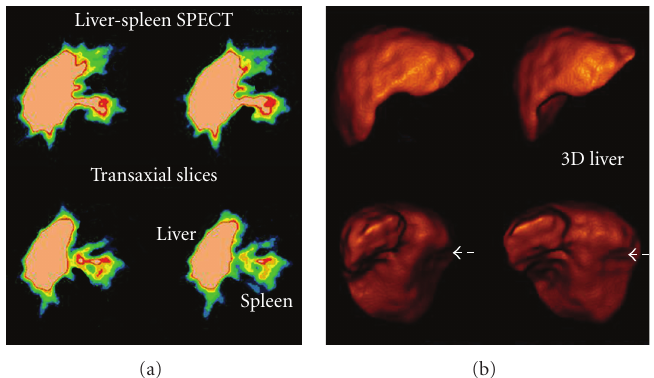
Figure 9: A liver-spleen study SPECT and 3D SPECT. (a) Transverse slices, prefiltered only by Ramp filter could emerge a small piece of the ruptured spleen. (b) 3D SPECT reconstruction by ramp-Hanning filters (Hanning cut-o ff frequency equal to 0.8 cycles/cm), a threshold 25% and 15% gradient, could show the liver and a short fracture in the middle of right lobe of the liver but misses any residual spleen fragment. ( Study has been o ff ered by Radiation Physics Unit, Department of Radiology, University of Athens).